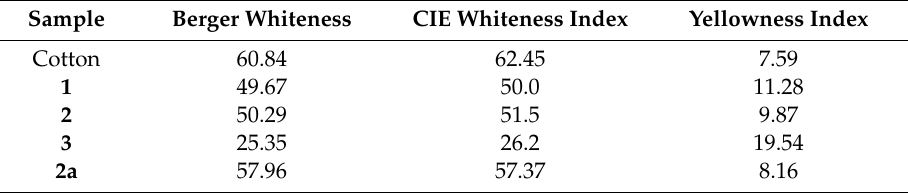
Table 4. E ff ects of the peptide functionalization on the whiteness degree of selected